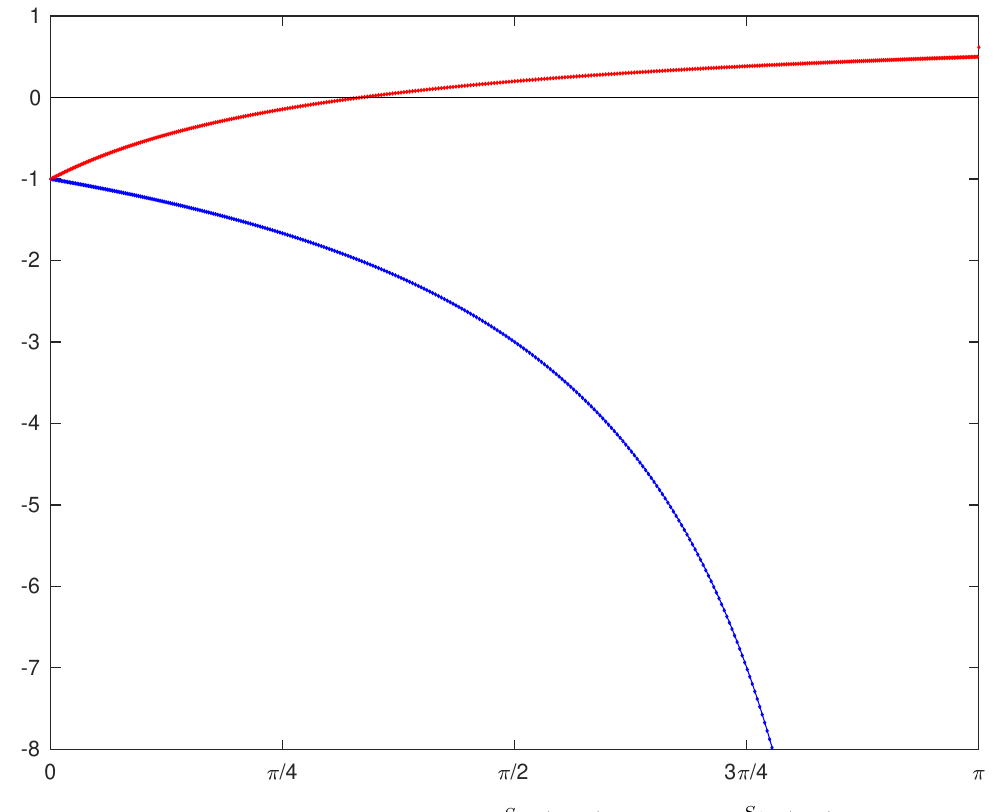
Figure 8. Plot of the numerical ratios R 1 = S I axis together with the (cid:12)t based on the naive ratios obtained from the zeros in the previous (cid:12)gure: ~ R (cid:18) + i(cid:25) , ~ R 2 = (cid:18) (cid:0) 1 : 048 i . The numerical results and the (cid:12)ts are 1 = (cid:18) (cid:0) i(cid:25) (cid:18) +1 : 048 i